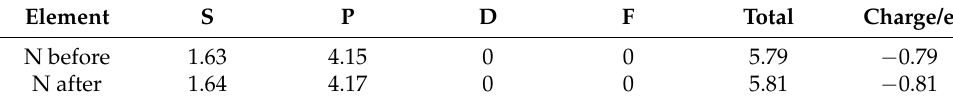
Table 7. Mulliken charges of NH 4 adsorbed on the (001) surface of